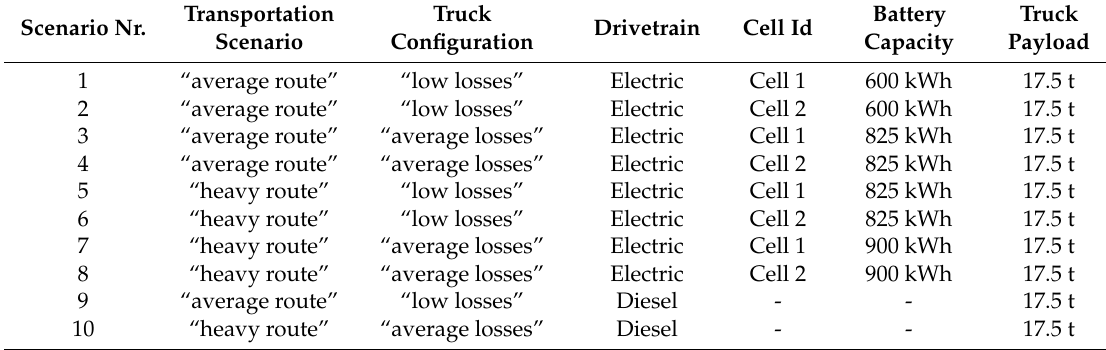
Table 4. Scenarios and main parameters considered for life cycle costs (LCC) calculation. Scenario Nr.